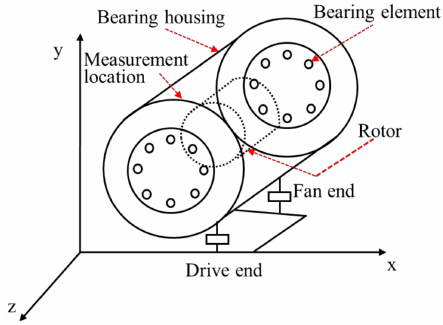
Figure 1. The system geometry, measurement location, and configuration of the